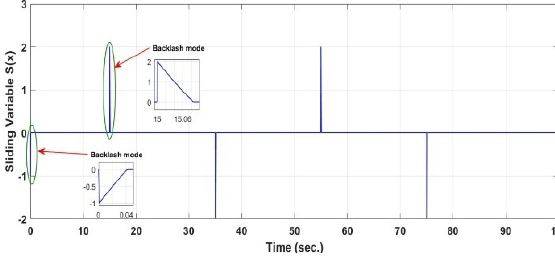
Figure 12. The sliding variables vs. time for both modes